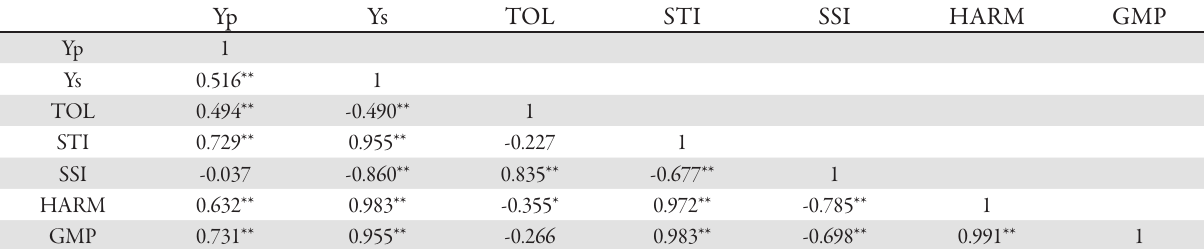
Tab. 5. Correlation coefficient between yield in 1/3 continuous irrigation stress level and drought tolerance indices